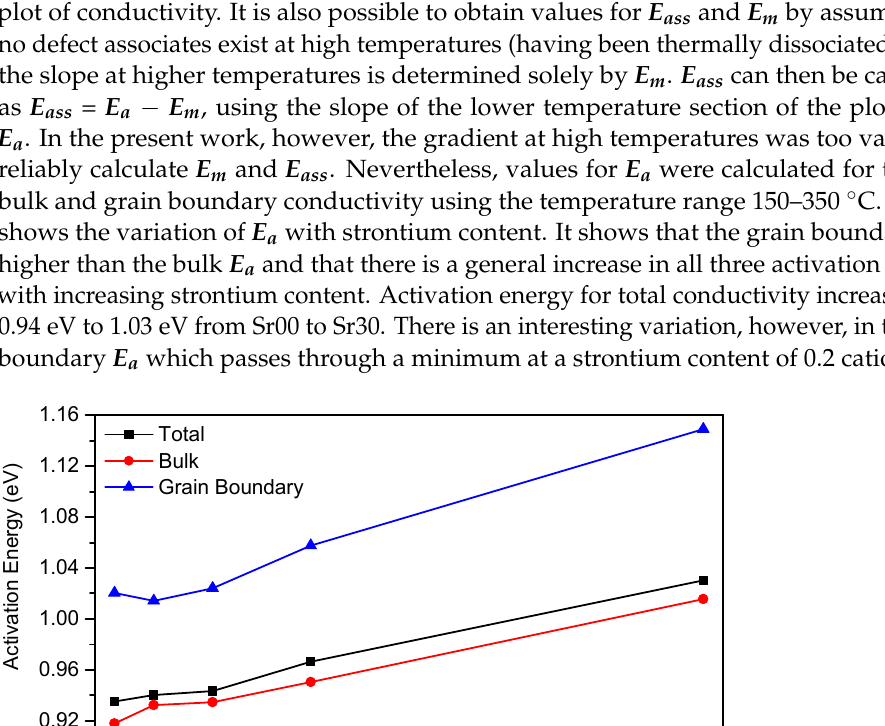
Figure 8. Arrhenius plots of ( a ) bulk and ( b ) grain boundary components of conductivity for the samples indicated.